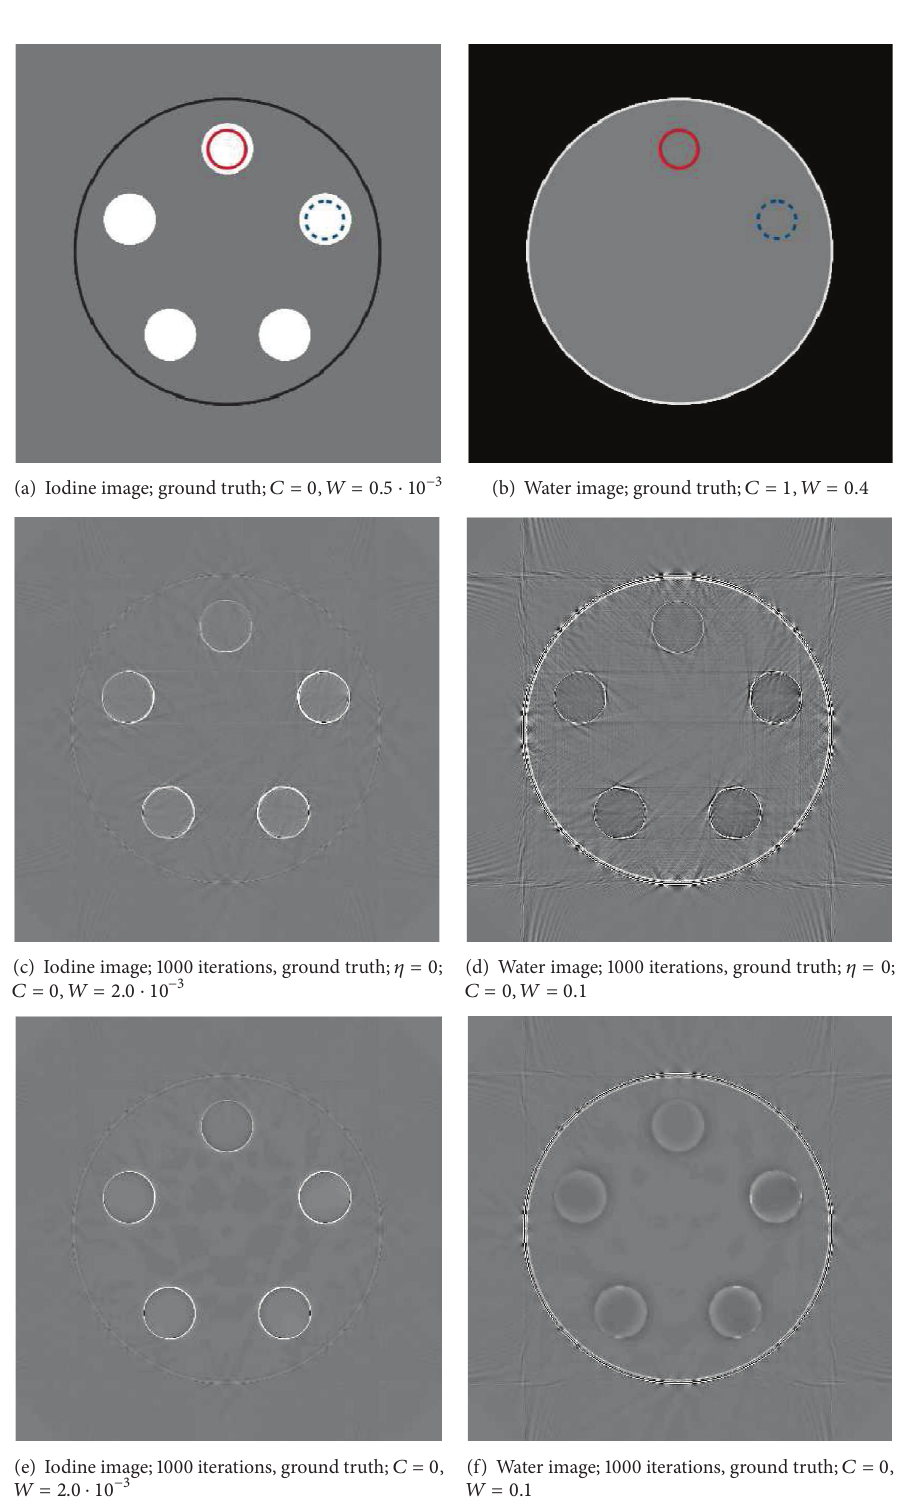
Figure 4: Reconstructed material images from data of an ideal PCD with the proposed algorithm with an energy resolution of 5 keV, after 1000 iterations and a subtraction of the respective ground truth